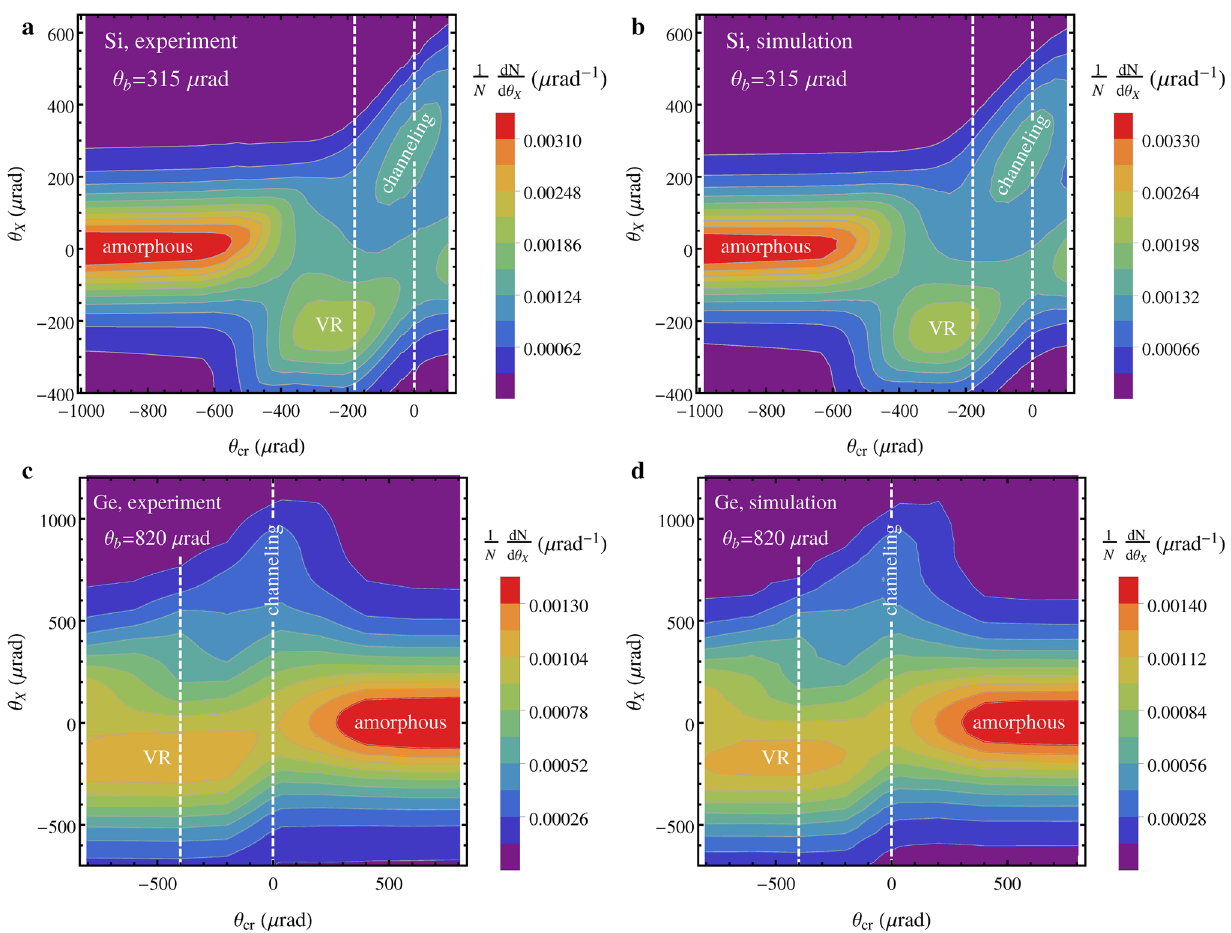
dashed lines represent the central orientation of the channeling and vol- ume reflection distributions displayed in Fig.